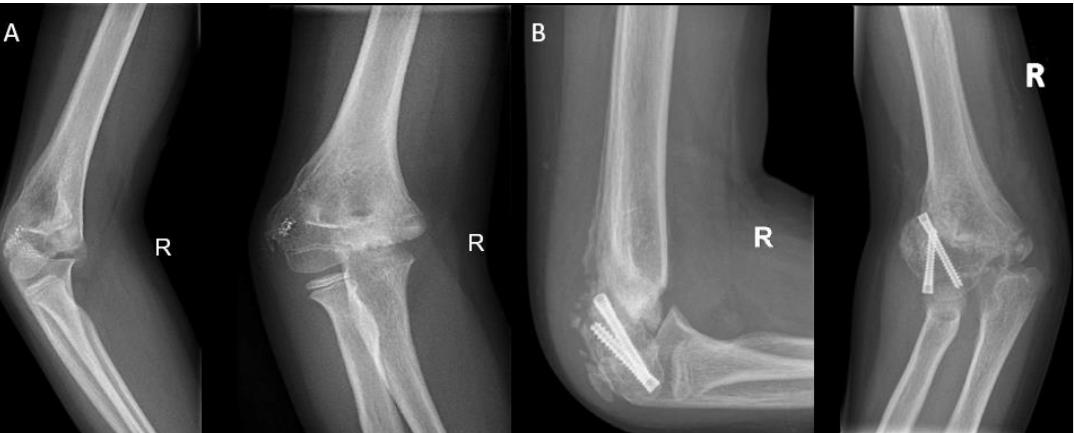
Figure 7. ( A ) Elbow radiographs of a 9-year-old girl with a posttraumatic cubitus varus, a flexion deficit of 60 degrees, and avascular necrosis of the medial condyle after a fall from height. ( B ) An epiphysiodesis using transphyseal screws was performed in addition to an arthrolysis with reduction of the coronoid fossa and release of the ulnar nerve.